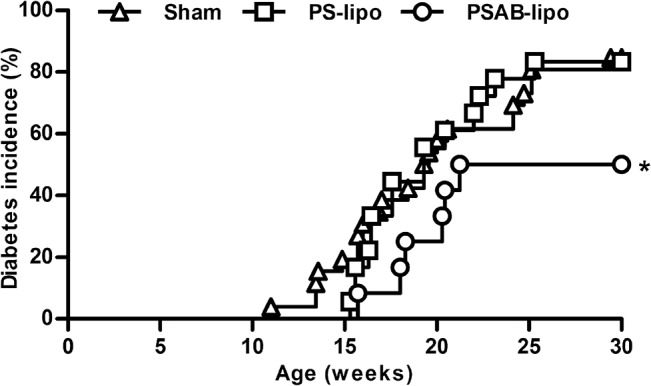
Immunotherapy using PS-liposomes filled with insulin peptides decreases T1D incidence.Cumulative incidence (percentage) of T1D in NOD mice treated with PSAB-liposomes (PSAB-lipo, circles, n = 12), PS-liposomes (PS-lipo, squares, n = 18), and sham group (triangles, n = 26). Significant differences were found when compared group treated with PSAB-liposomes versus sham group (*p≤0.05, Kaplan-Meier log-rank analysis).